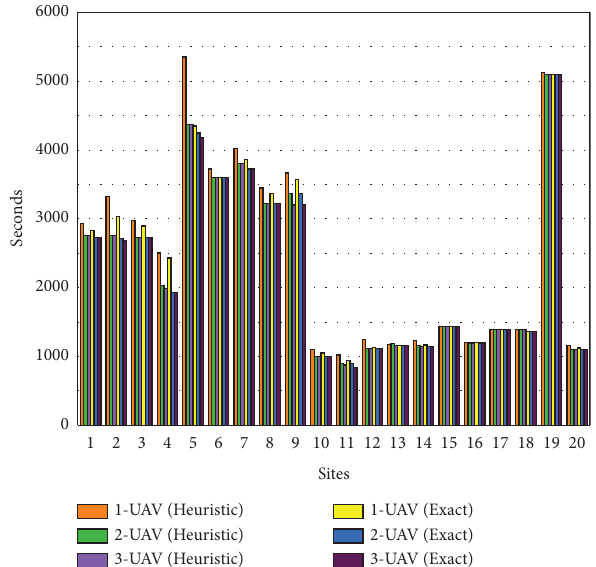
Figure 5: Comparison of heuristic and exact solution times.